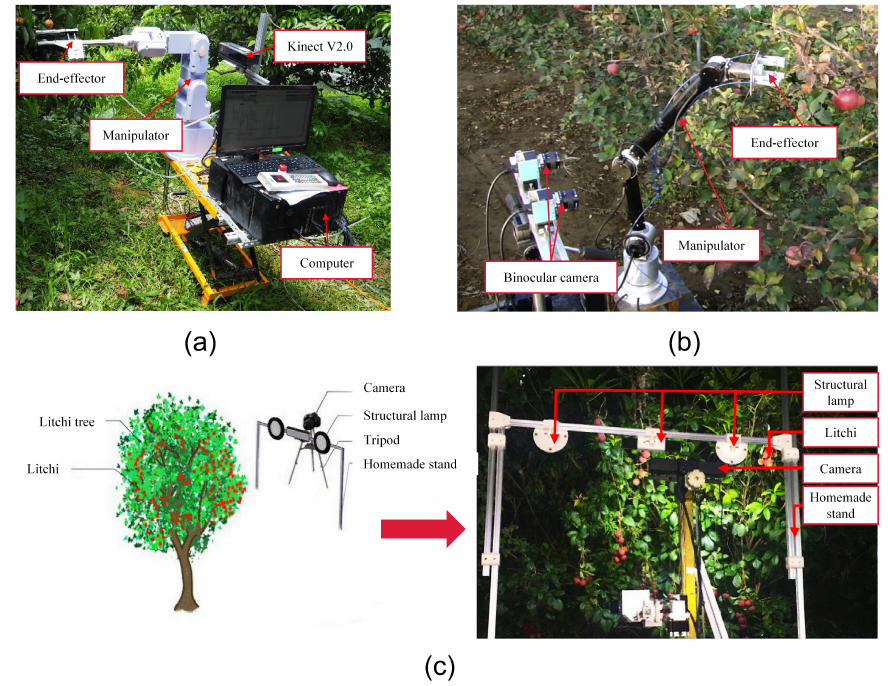
Figure 1. Representative forms of picking robots. ( a ) Litchi-harvesting robot (Adapted with permis- sion from Ref. [8]. 2020, Li et al.); ( b ) Apple-harvesting robot (Adapted with permission from Ref. [9]. 2015, Si et al.); ( c ) Another litchi-harvesting robot (Adapted with permission from Ref. [10]. 2020, Liang et